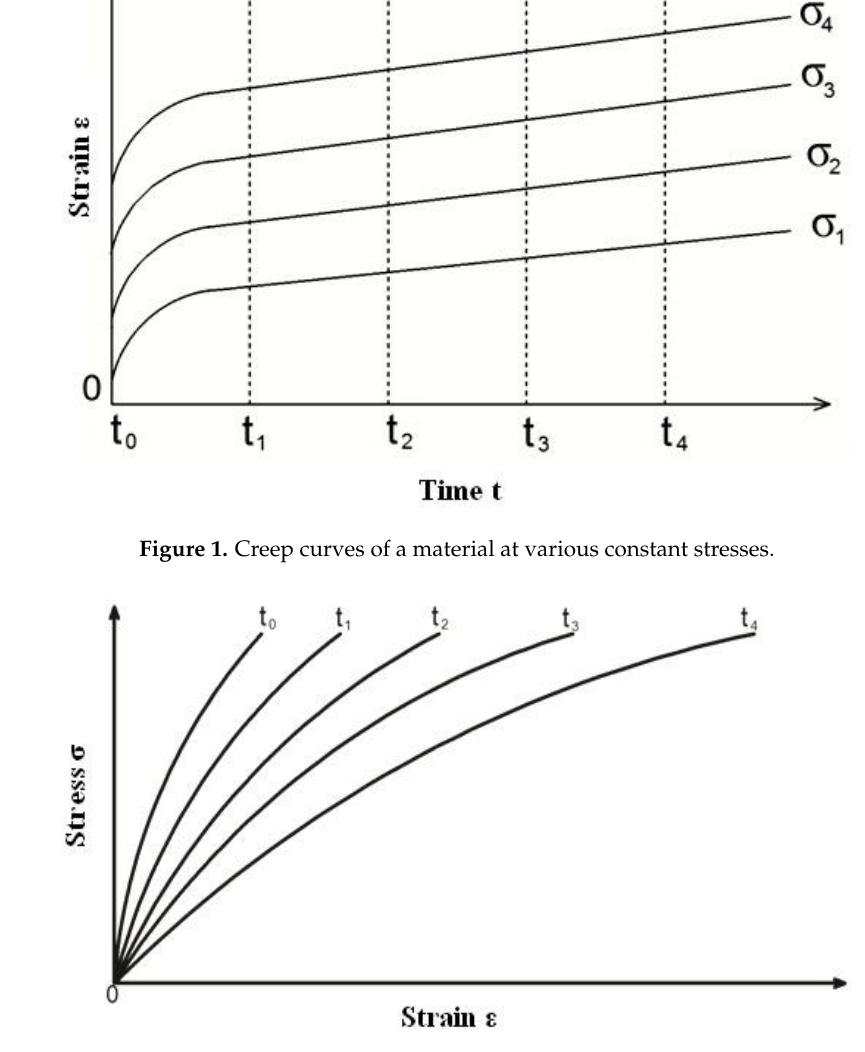
Figure 2. Isochronous deformation curves of a material.